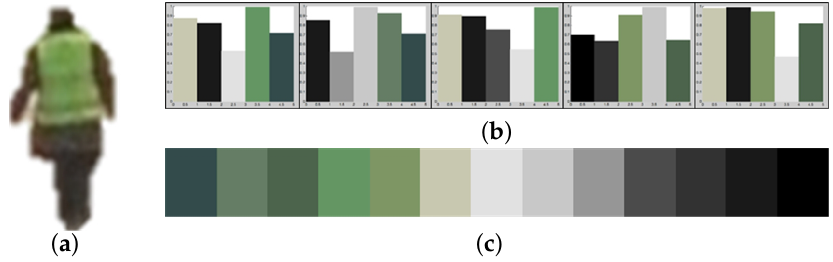
Figure 9. Results of K-means clustering to extract representative colors of the same object using different sets of initial clusters: ( a ) input image; ( b ) different results of K-means clustering; and ( c ) the sorted colors of (b).